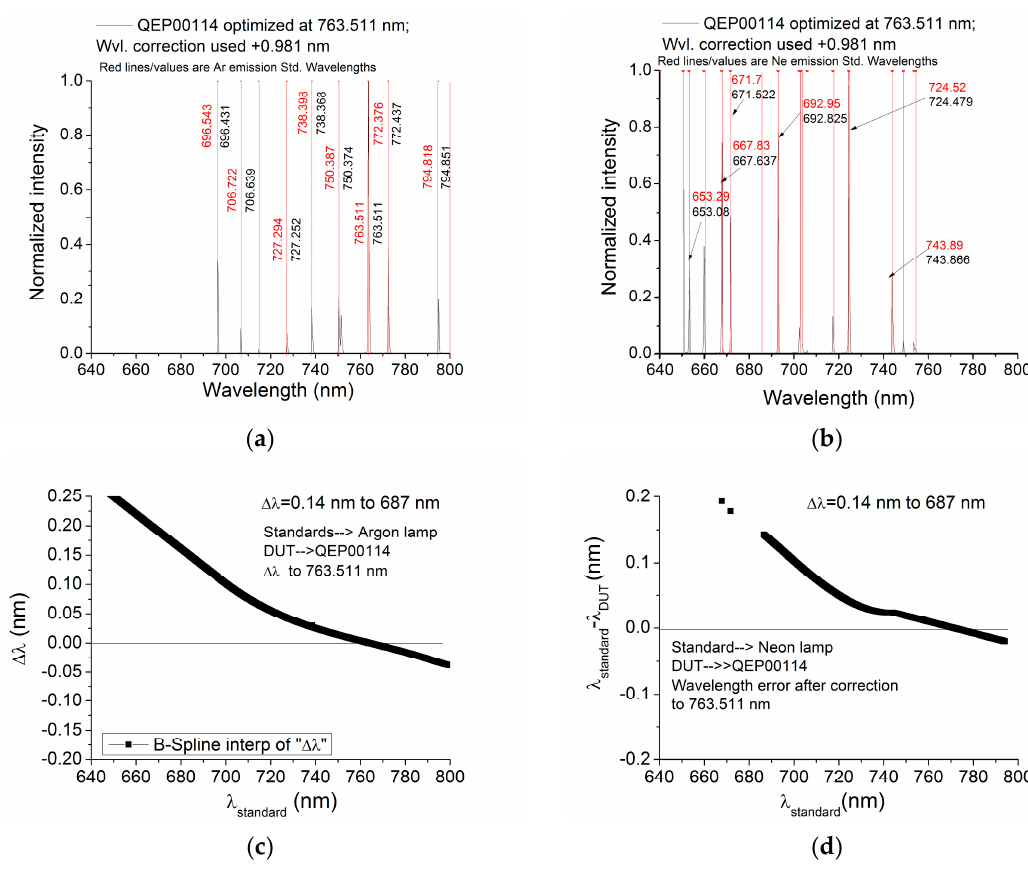
Figure 9. The wavelength corrections for ( a ) Ar and ( b ) Ne lamps’ emission lines measured with the QEP00114 ( λ DUT ; DUT, device under test) after optimization at 763.511 nm and the corresponding errors ( c , d ) related to the standard values ( λ standard ). The red lines represent the standard emission lines for Ar and Ne lamps.